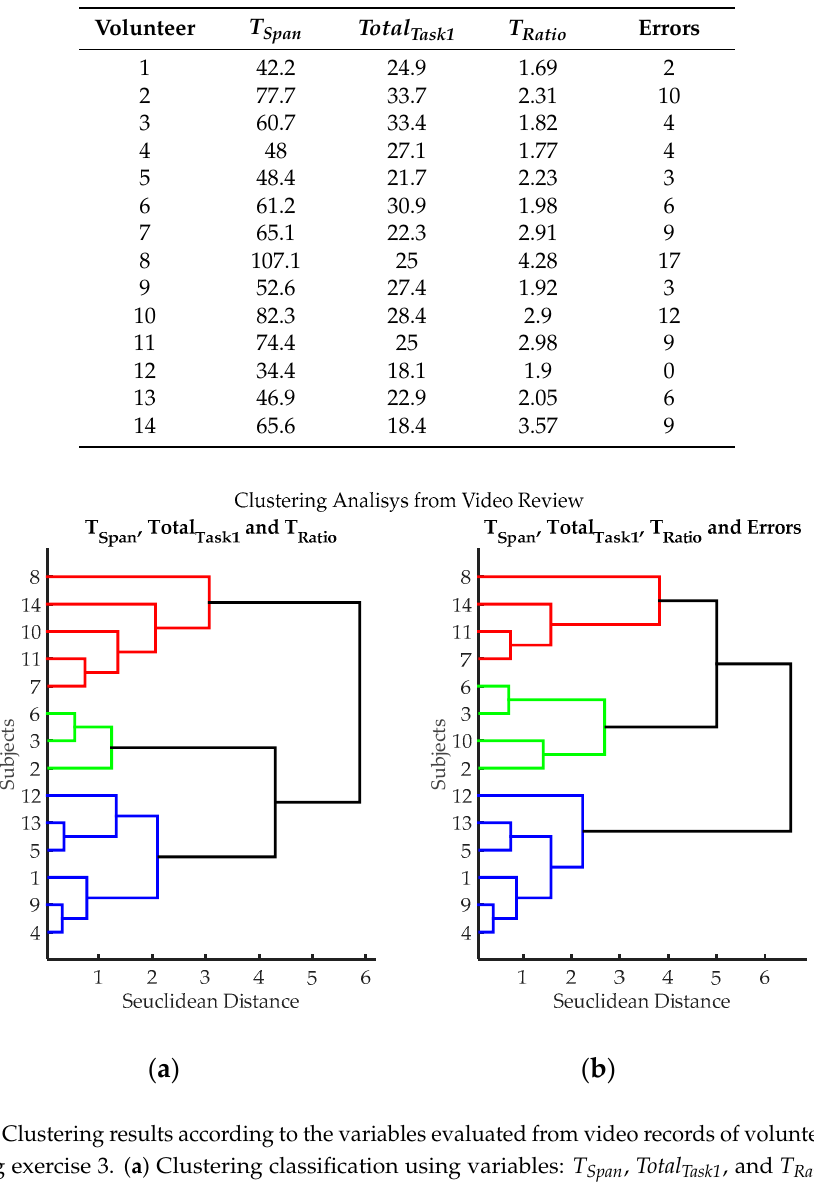
3.2. Results from IGlove Data Processing 3.2.1. Exercises Segmentation Figure 8 shows the results of the segmentation algorithm for each of the exercises. The upper graph corresponds to the signal of a gyroscope from one of the participants (Sensor 1, gyroscope on Z-axis), (cid:1845) (cid:3008)(cid:2869)(cid:3053) acquired throughout the whole test (the signal from any of the 12 gyroscopes on IGlove could be used). An envelope of this signal (cid:3627)(cid:1845) (cid:3008)(cid:2869)(cid:3053) (cid:3554) (cid:3627) , was calculated using the absolute value of the Hilbert transform of (cid:1845) (cid:3008)(cid:2869)(cid:3053) shown in the second graph (in green), it is a smooth curve that outlines the peaks of (cid:1845) (cid:3008)(cid:2869)(cid:3053) and eliminates most of zero crossings. The envelope signal was passed through a comparator. The comparator output is 100% when (cid:3627)(cid:1845) (cid:3008)(cid:2869)(cid:3053) (cid:3554) (cid:3627) is higher than a Threshold (the threshold is 15 degrees per second, which is high enough to avoid false activation). If (cid:3627)(cid:1845) (cid:3008)(cid:2869)(cid:3053) (cid:3554) (cid:3627) is lower than Threshold , the output is set to 0%, indicating a rest period. Small false-positives can be found from time to time in the output signal, mainly caused by small involuntary movements. Also, the output may drop to 0% for short intervals when zero-crossings were found on (cid:3627)(cid:1845) (cid:3008)(cid:2869)(cid:3053) (cid:3554) (cid:3627) signal. To overcome these small errors, all peaks in the output of the comparator signal with a duration time of one second or less were eliminated; similarly, all small timeslots (holes) with output at 0% were filled. Table 3 shows the estimated duration time of each exercise.